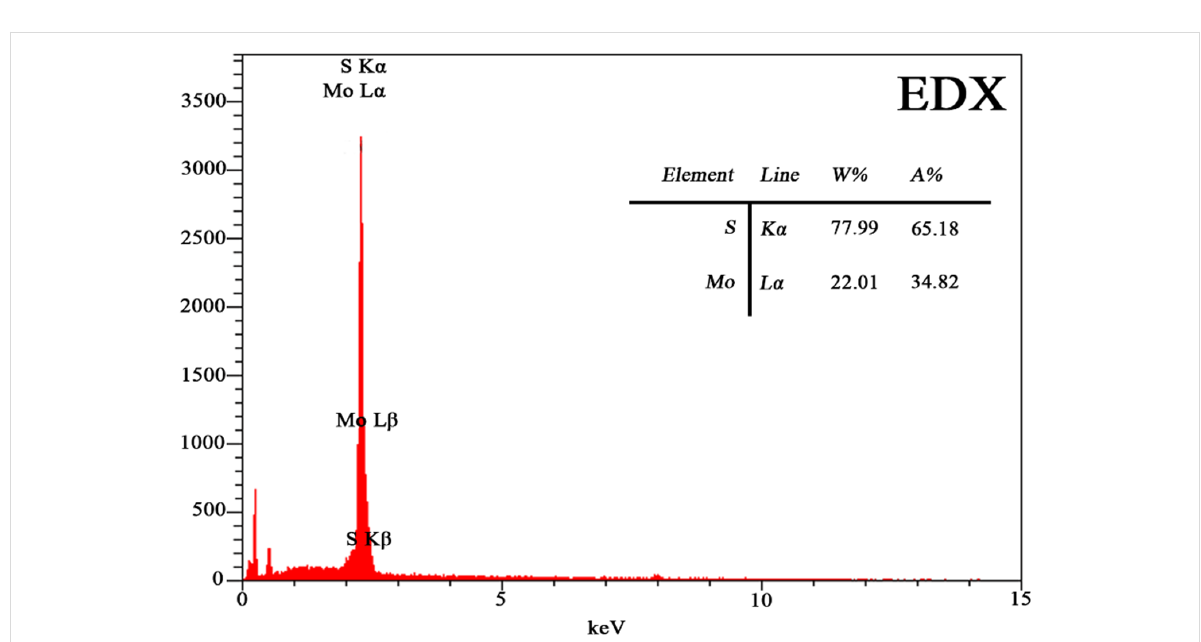
Figure 3: EDX analysis of MoS 2 nanoflake powder as prepared by the aqueous hydrothermal